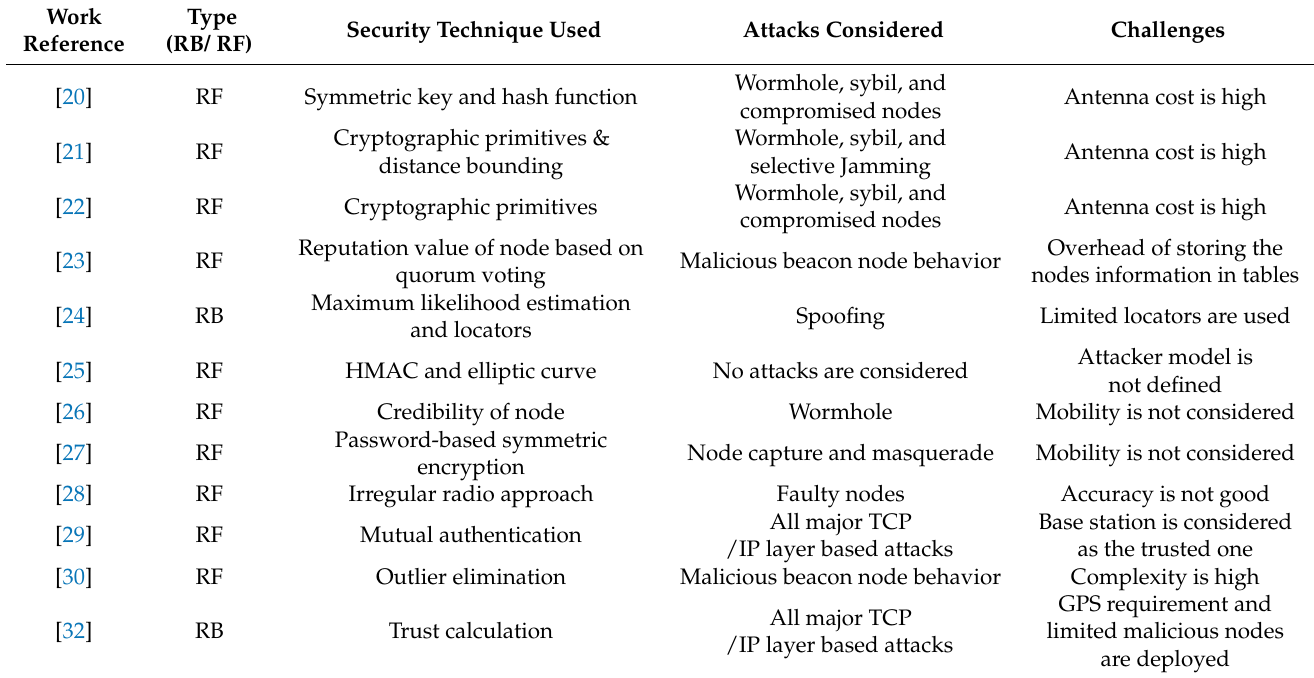
Table 1. Comparative analysis of secure localization